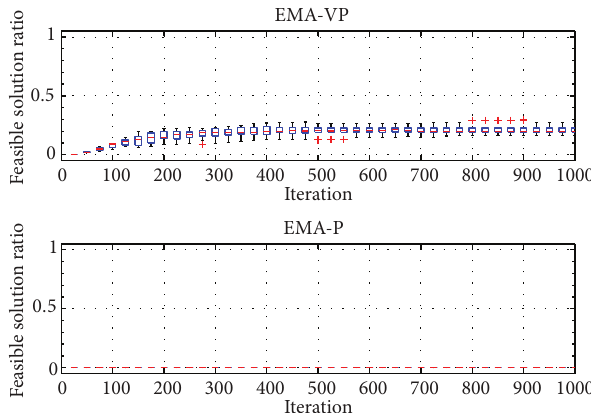
Figure 10: Ratio of feasible solutions for EMA-VP and EMA-P for RC